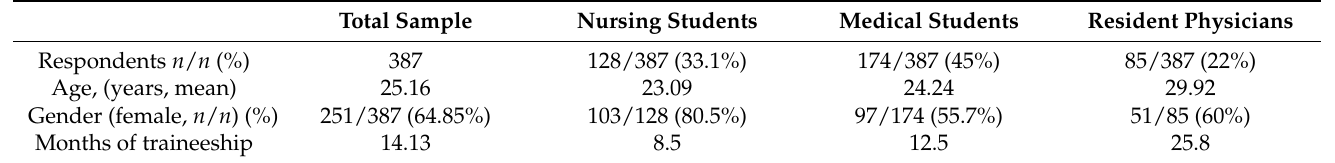
Table 1. Description of participant